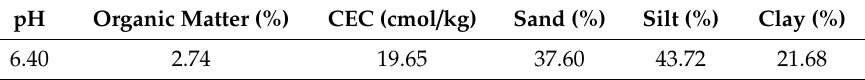
Table 1. Physical and chemical properties of soil